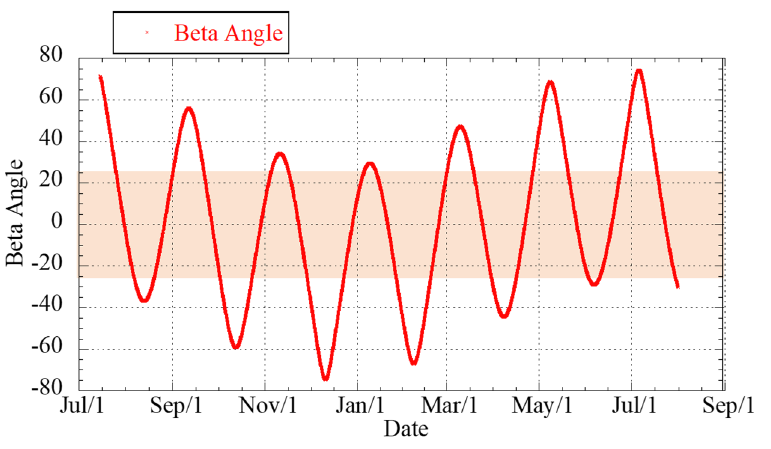
Figure 19. Beta angle variation of KITSUNE for one year from July 2022 to September 2023.